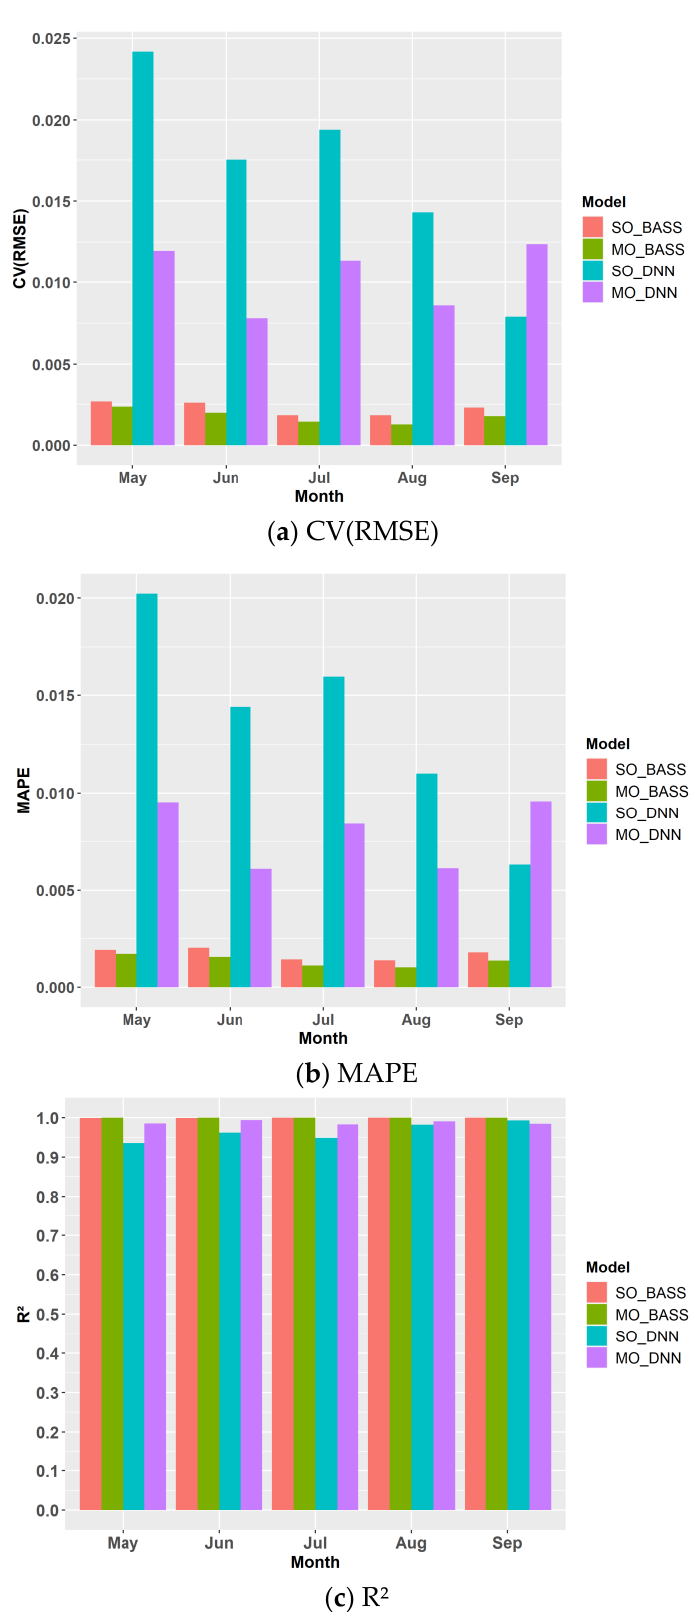
Figure 7. Prediction performance of four machine learning models for monthly cooling energy (SO, single output; MO, multiple output).